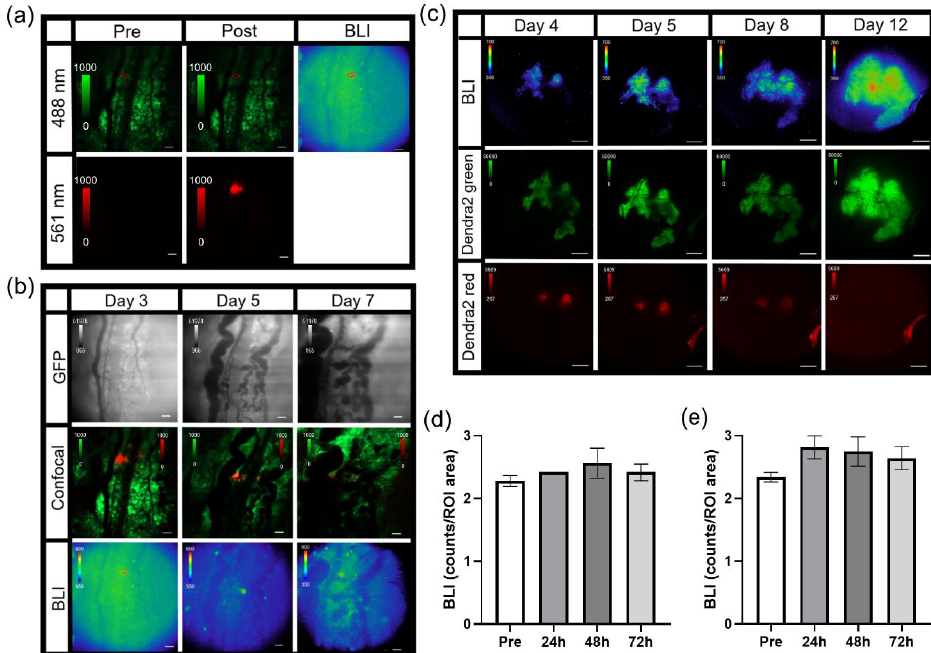
Figure 5. Photoswitching B16F10 NF- κ B-FLuc Dendra2 tumor cells and tumor areas. ( a ) Representative intravital confocal images (4.8 speed, laser lines: 488 nm (green unphotoconverted Dendra2) and 561 nm (red photoconverted Dendra2)) pre and post single cell photoconversion using the 405nm laser line and corresponding bioluminescence image (BLI, 20 min acquisition, open filter) at 10X; scale bar represents 100 µ m. ( b ) Representative intravital microscopic image of B16F10 NF- κ B-FLuc Dendra2 tumors over time following 405 nm confocal laser photoconversion of Dendra2 epifluorescence (GFP cube, 200 ms exposure), merged Dendra2 confocal image (green unphotoswitched and red photoswitched Dendra2) and NF- κ B-FLuc bioluminescence image at 10X. ( c ) Representative intravital image of B16F10 NF- κ B-FLuc Dendra2 tumors over time following photomarking larger tumor areas at 2X of NF- κ B-FLuc bioluminescence (BLI), green unphotomarked Dendra2 (Dendra2 green, GFP cube, 2 s exposure), and red photomarked Dendra2 (Dendra2 red, DsRed cube, 5 s exposure). Quantification of NF- κ B-FLuc bioluminescence prior to (pre) and at indicated time points post Dendra2 photoconversion of ( d ) whole tumor, and ( e ) photoconverted areas of the tumor (data are represented as mean ± SEM, n = 6